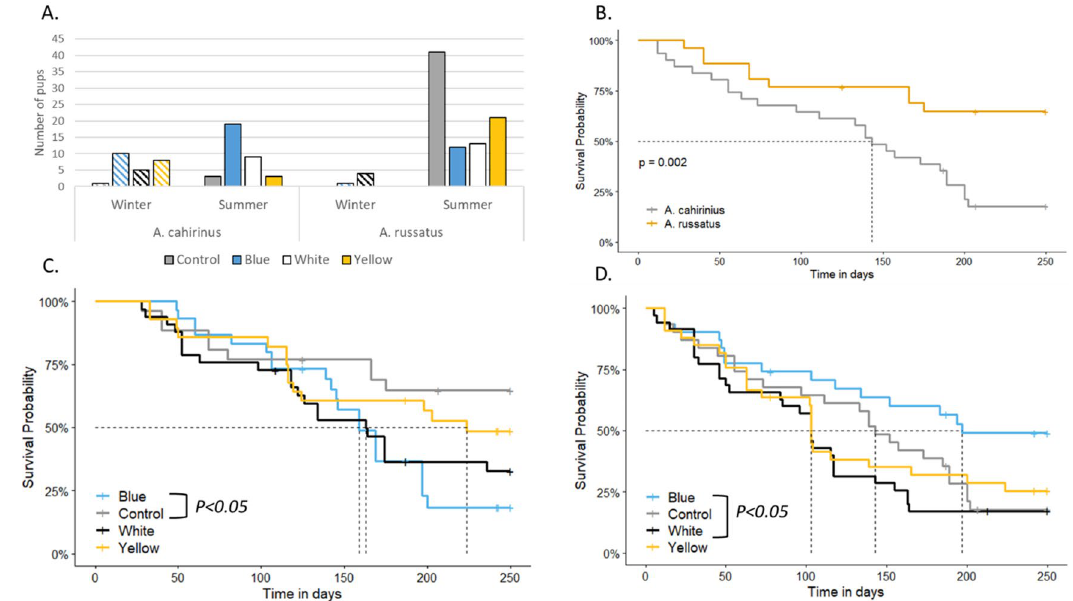
Figure 2. Population data: ( A ) newborns across all treatments for 2 years, divided by season. For more information regarding number of females in each treatment and season, see Supplementary Material Table S2; ( B ) survival probability of the two species from the control group; ( C ) survival probability of A. russatus across treatments; ( D ) survival probability of A. cahirinus across treatments. Dashed lines show the median survival probability of each